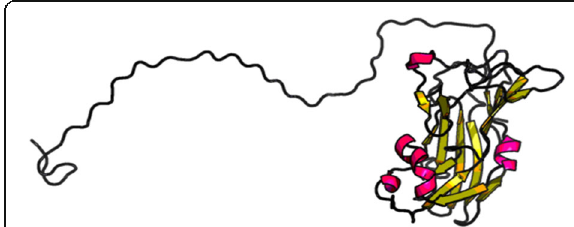
Fig. 5 Homology model of canine lysyl oxidase protein by RAPTORX . Human LOX homolog 2 (5ze3.1.A) was used a modeling template with a significant similarity with the query sequence. The predicted oligo state of the protein model was monomer